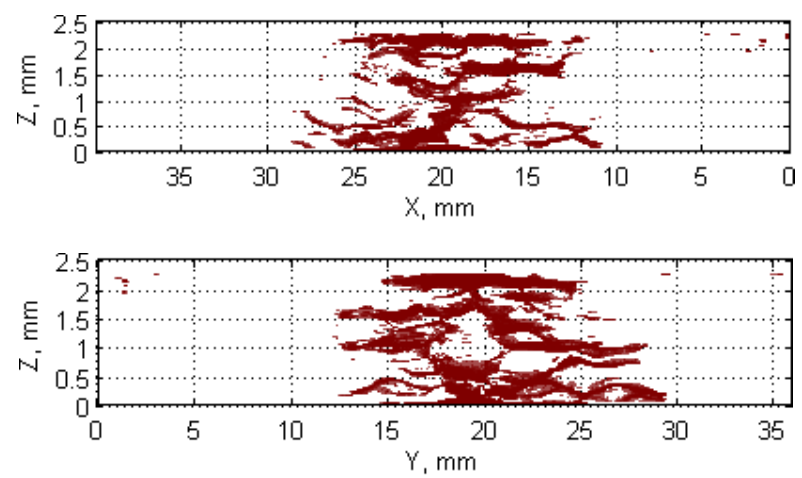
Figure 21. Visualization of the reconstructed damage based on X-ray CT scans.